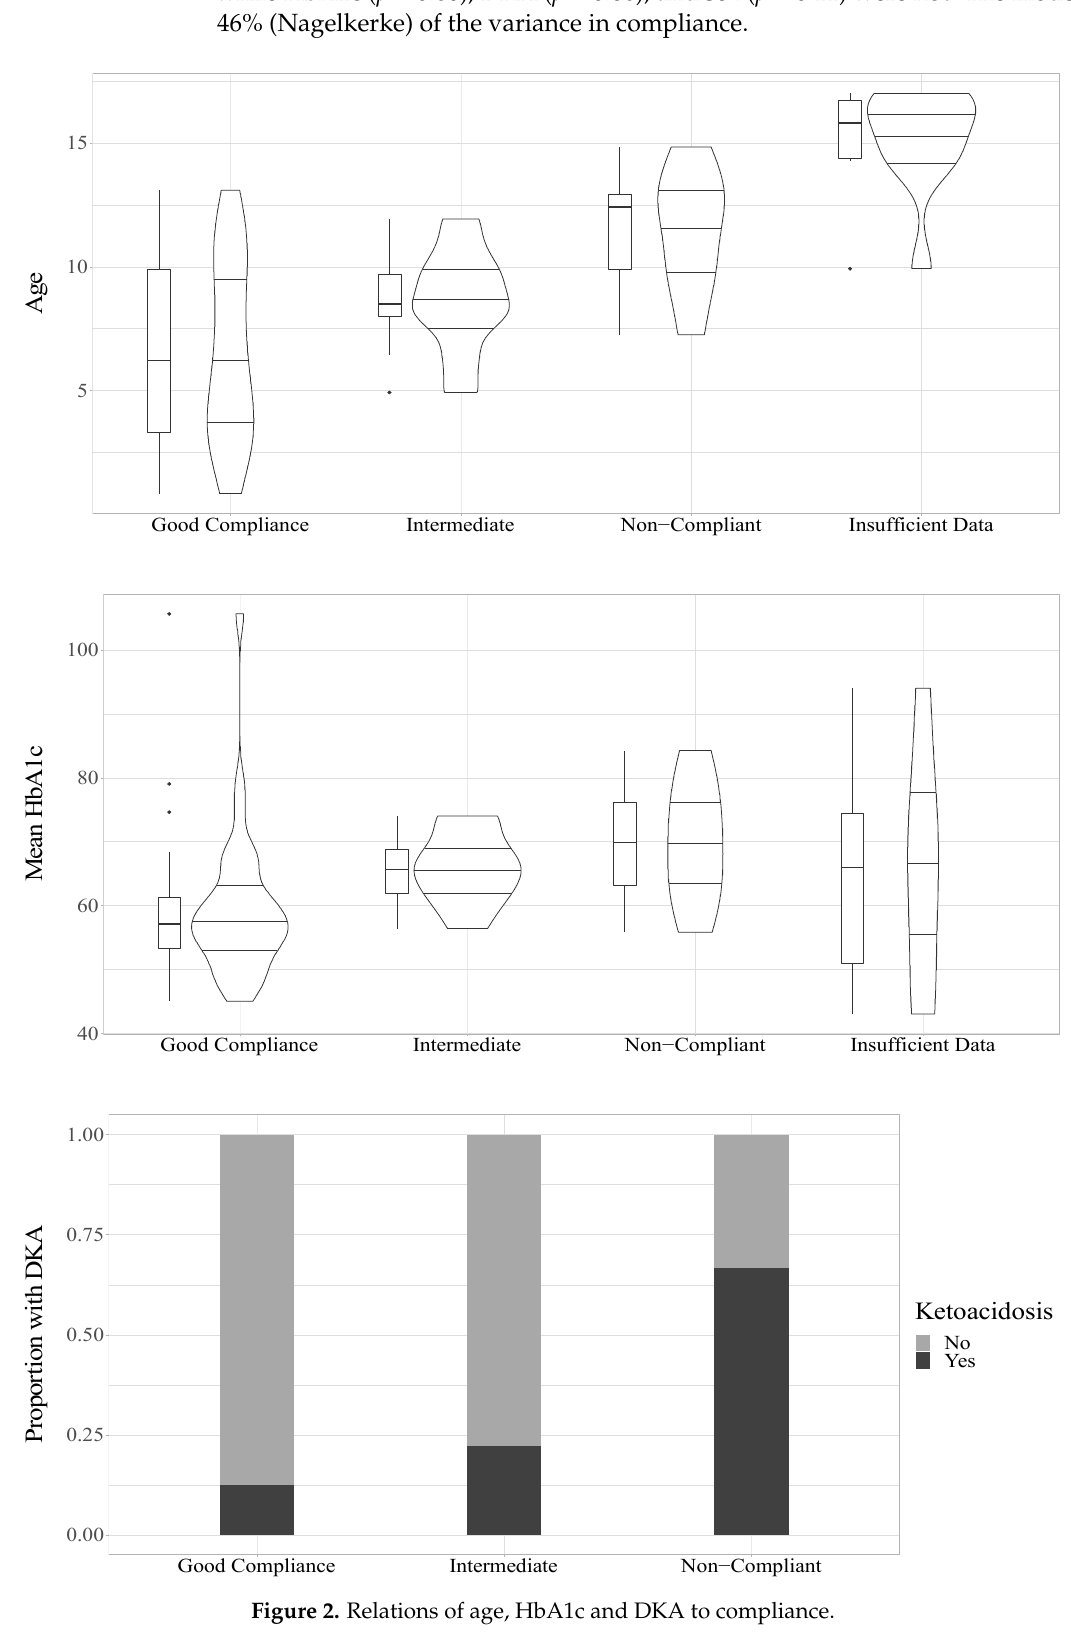
Figure 2. Relations of age, HbA1c and DKA to compliance.